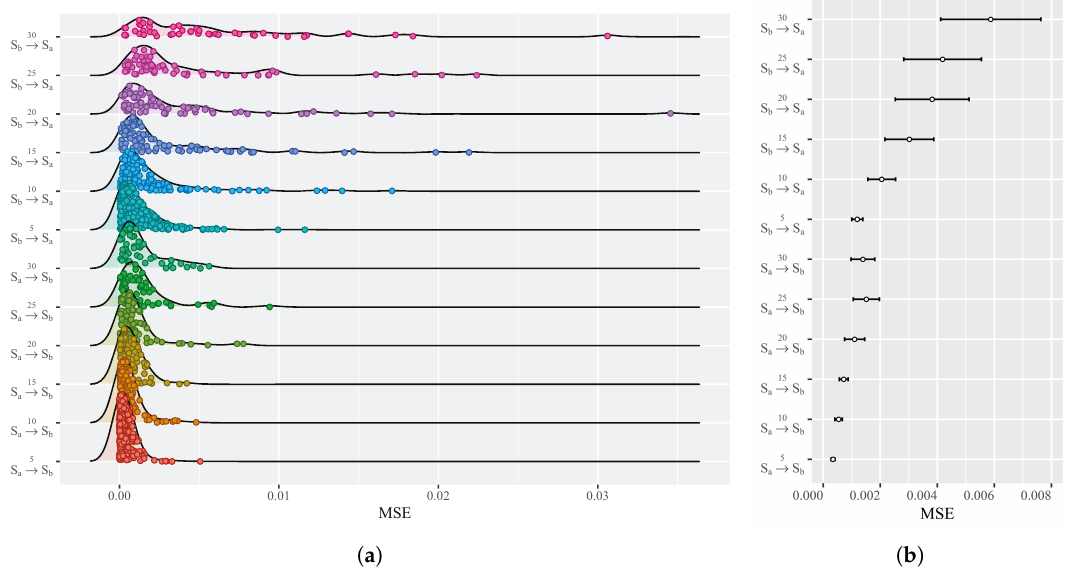
Figure 4. MSE. ( a ) Distribution of MSE for type and interval. ( b ) 95% family-wise confidence